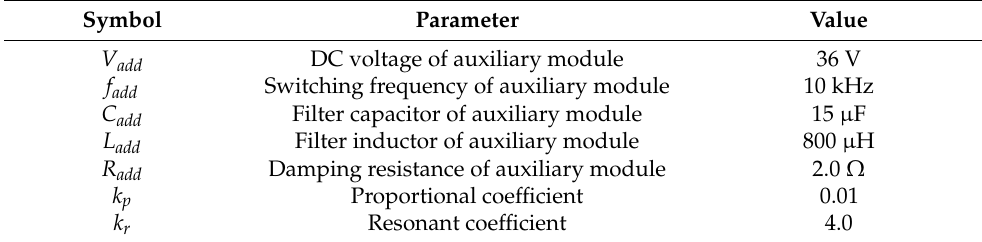
Table3. Operating parameters of main circuit used in experiments.